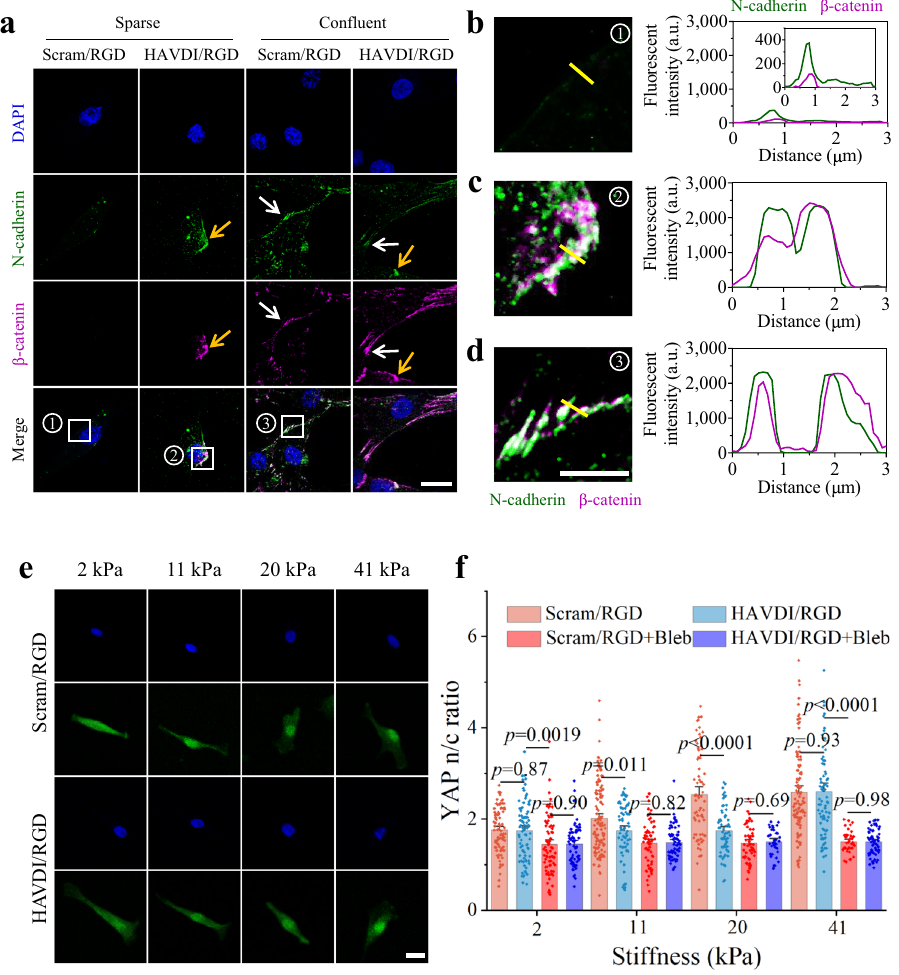
Fig. 2 N-cadherin clustering and β -catenin recruitment in mimetic PEG hydrogels and stiffness dependent YAP nuclear localization via N-cadherin signaling. a HAVDI ligation caused sparse cells to adopt the N-cadherin and β -catenin patterning of con fl uent cells, as evident from confocal images of DAPI (blue), N-cadherin (green) and β -catenin (purple) staining in hMSCs cultured on either sparse (non-con fl uent) or con fl uent conditions on Scram/ RGD or HAVDI/RGD hydrogels of Young ’ s modulus 20 kPa. The white arrow highlights real cell-cell adhesions between neighboring hMSCs; the yellow arrow highlights N-cadherin/HAVDI binding for an isolated hMSC on a HAVDI/RGD hydrogel. Scale bar: 20 μ m. b – d Representative subcellular distributions of N-cadherin and β -catenin in three different cases corresponding to the numbered areas shown in a , showing that HAVDI ligation caused sparse cells to adopt the N-cadherin and β -catenin patterning of con fl uent cells. Scale bars: 5 μ m. b Isolated cells on Scram/RGD hydrogels, which do not mimic cell-cell adhesions, did not show substantial N-cadherin clustering or β -catenin recruitment. c Isolated cells cultured on HAVDI/RGD hydrogel, which mimicked cell-cell adhesions, showed N-cadherin clustering or β -catenin recruitment that was indistinguishable from that in d con fl uent cells on Scram/RGD hydrogels. Yellow lines in b – d indicate the pixel regions of interest used to generate intensity pro fi les of N-cadherin (green) and β -catenin (purple). e Confocal images of YAP immunostaining on hMSCs cultured on 2, 11, 20 and 41 kPa Scram/RGD or HAVDI/RGD hydrogels for 3 d. Scale bars, 20 μ m. f Quanti fi cation of YAP n/c ratios on Scram/RGD or HAVDI/RGD hydrogels of increasing stiffness with or without blebbistatin (myosin inhibitor) as shown in e (from left to right n = 82, 87, 79, 74, 126, 71, 60, 65, 71, 68, 53, 35, 105, 82, 39, 63 cells examined over 14, 13, 16, 18, 17, 16, 27, 19, 15, 13, 19, 24, 9, 9, 23, 27 images respectively, p values were obtained using one-way ANOVA followed by Tukey ’ s post hoc test, mean ± s.e.m.). Source data